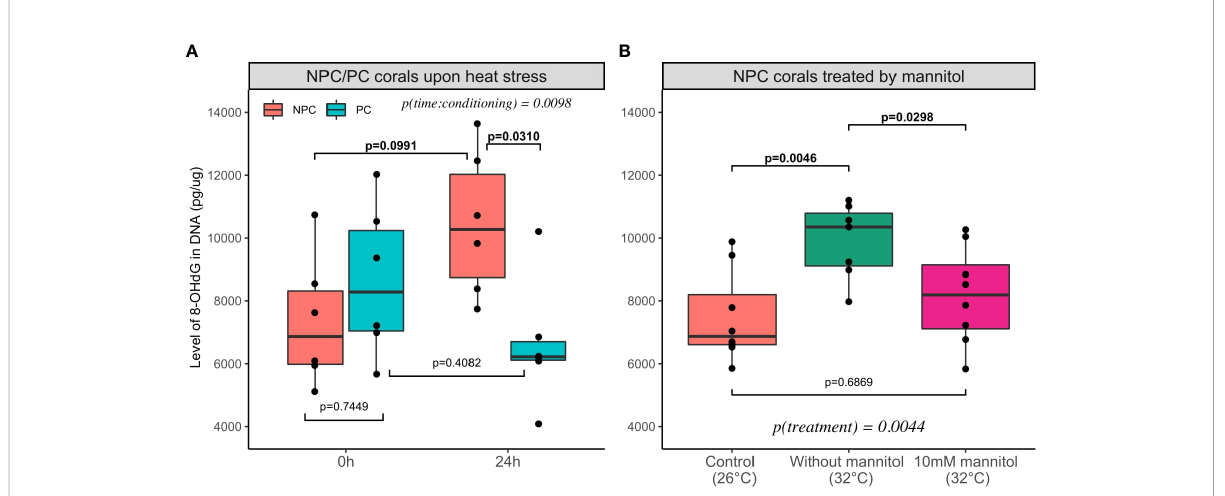
FIGURE 3 Oxidative DNA damage during heat stress. (A) Non-preconditioned corals accumulate DNA damage (the oxidized guanine species, 8-OHdG) but preconditioned corals do not. After 24 hours of the stress, there is a signi fi cant difference in the level of 8-OHdG between the treatments. n = 6 (B) The accumulation of 8-OHdG in non-preconditioned corals during acute heat stress is prevented by the addition of 10 mM mannitol, a non- enzymatic antioxidant. n = 8. The boxplots show median of the data, fi rst and third quartile and respective